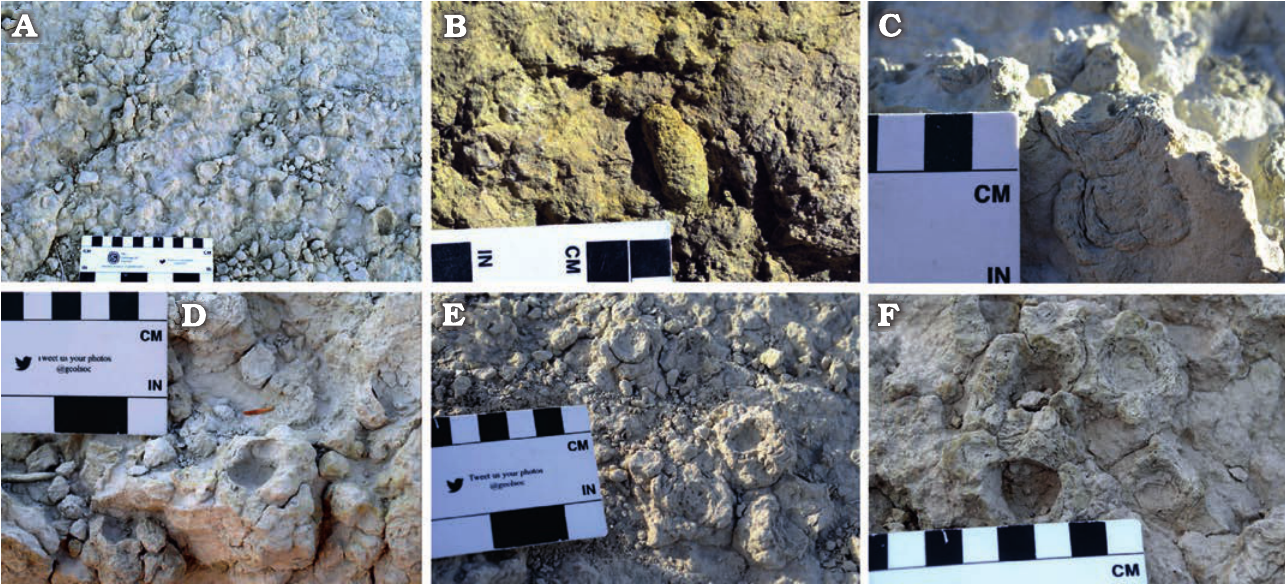
Fig. 7. Ichnofossils in the Pipestone Springs strata. A . Example of ichnofossils in the A horizon. B . Elongate ellipsoidal trace similar in morphology to Rebuffoichnus . C . Cylindrical to elliptical structure, partly walled, with meniscate backfill, similar to dung sausages of modern dung beetle nests. D . Helical constructed structure composed of pelletized sediment pressed together to form a wall with meniscate backfill or massive backfill, similar to Eatonichnus . E. Constructed spheres with an opening to a concave hemispherical impression, similar in morphology to Coprinisphaera and Feoichnus. F . Structures composed of meniscate backfills in a rosette pattern that is subsequently hollowed out into a hemisphere with architectural elements of Coprinisphaera , Eatonichnus , Feoichnus , and